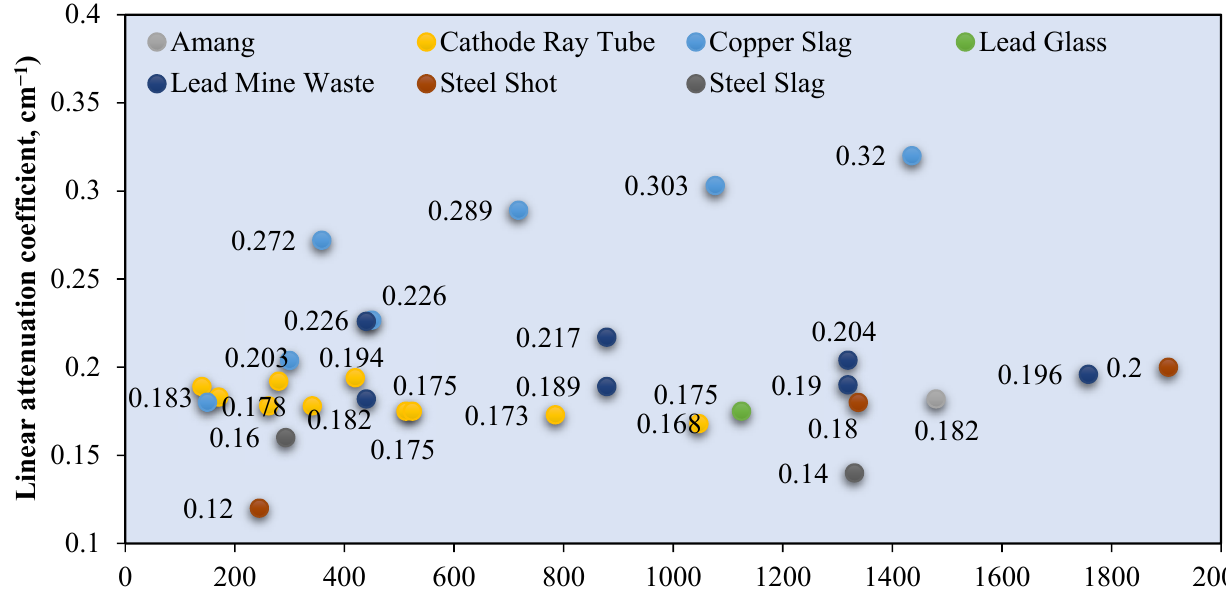
Figure 9. Relationship between linear attenuation coefficient (cm − 1 ) and amount of waste per cubic meter of concrete (kg/m 3 ) (data adapted from [14,24,65,88,95,106,120,122]).